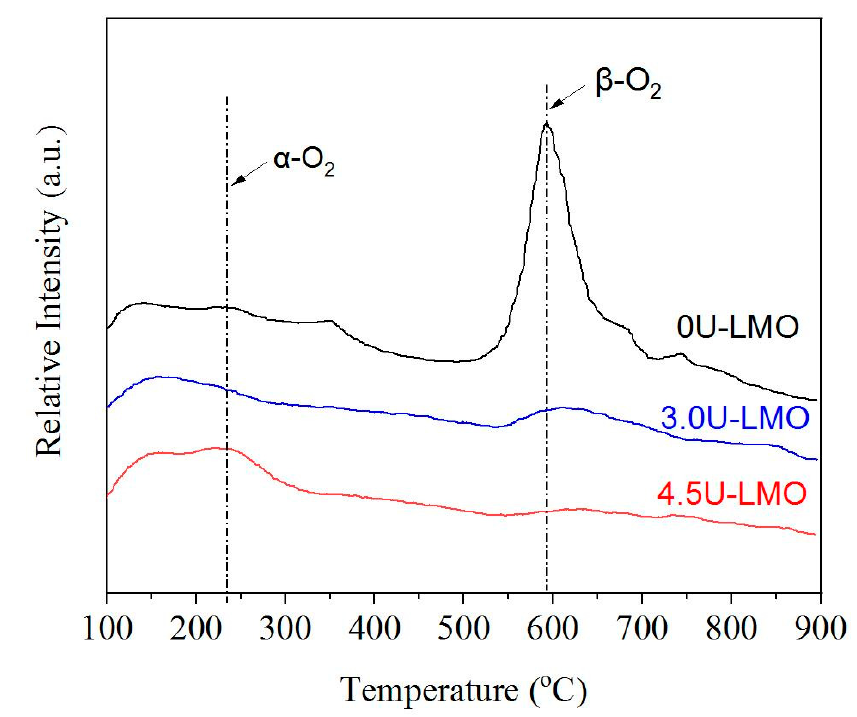
Figure 5. O 2 -TPD curves of LMO, 3.0U-LMO, and 4.5U-LMO